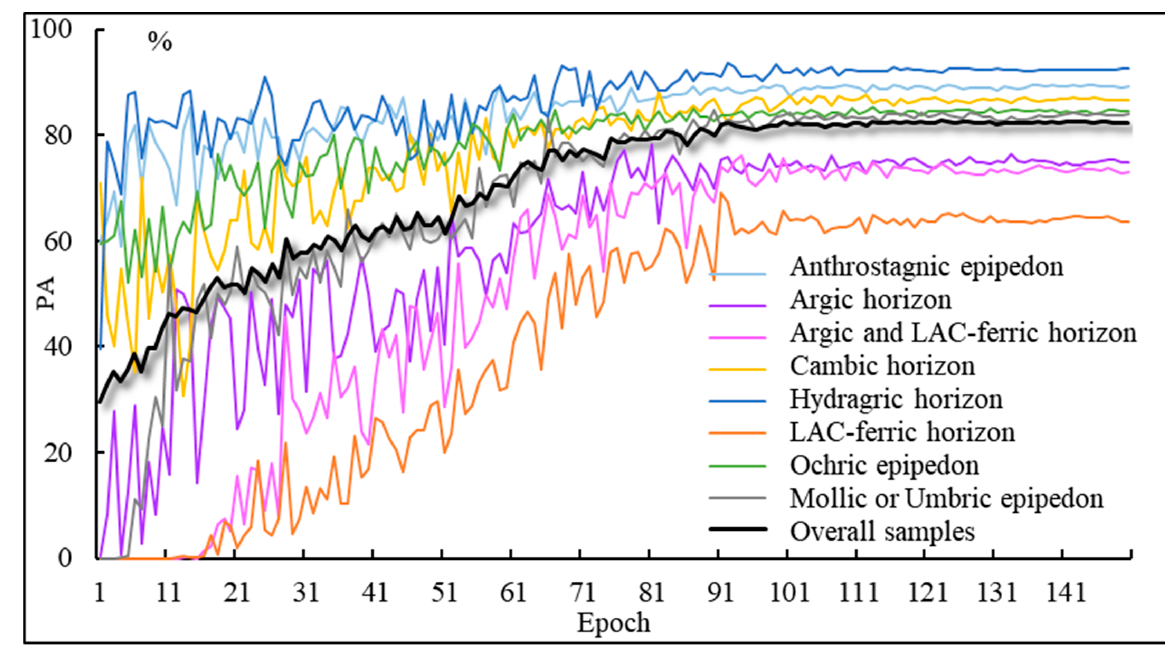
Figure 11. Changes in PA with epoch. Table 4. Different metrics of the models generated in the 123rd and 148th epochs. The standard deviation indicates the standard deviation of the corresponding indicator for all diagnostic